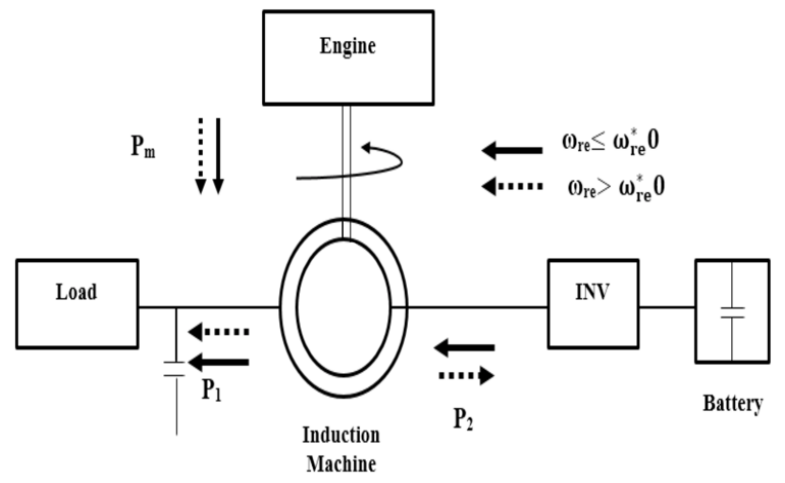
Figure 9. Wound-rotor induction generator [65]. (∗ ) Reference speed .